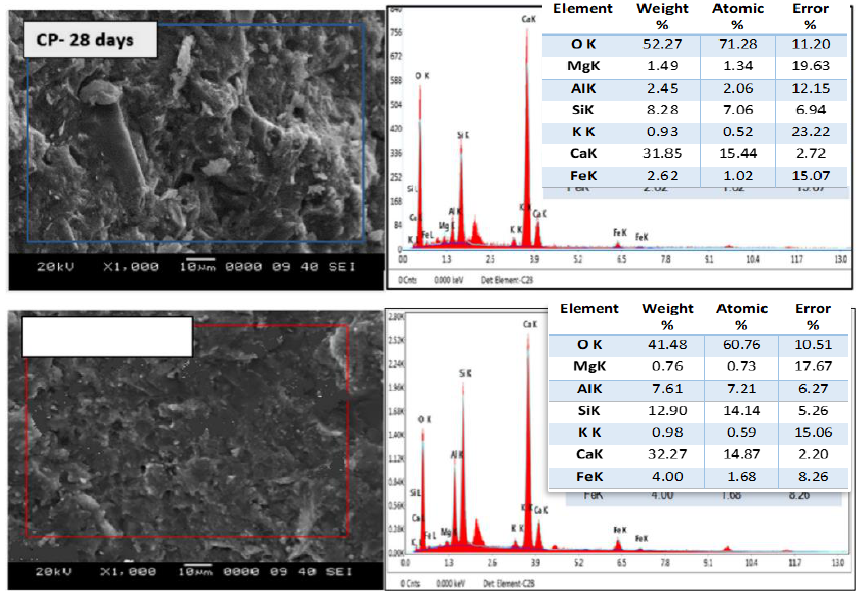
Figure 7. ( a ) Infrared spectrum analysis. ( b ) Thermogravimetric analysis and heat flow analysis of cement and NS [61].